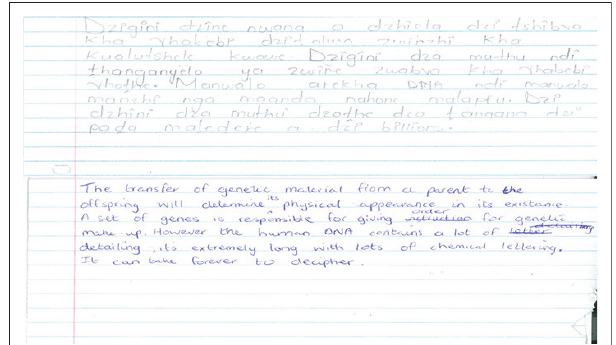
FIGURE 1: Excerpt